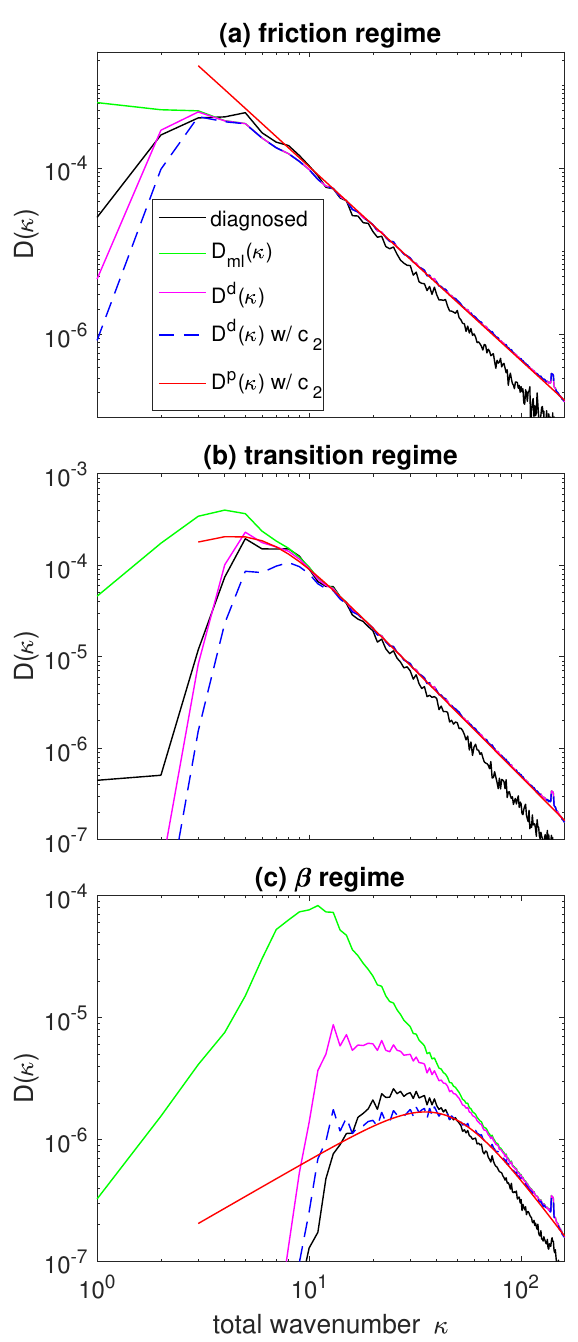
Figure 4. Diagnosed and predicted eddy diffusivity spectra for the same three simulations as in Figure 1 (see legend and text for an explanation of the different theoretical spectra). Notice that the prediction D p ( κ ) assumes no energy (and thus no eddy transport) at wavenumbers below the frictional halting scale κ frc